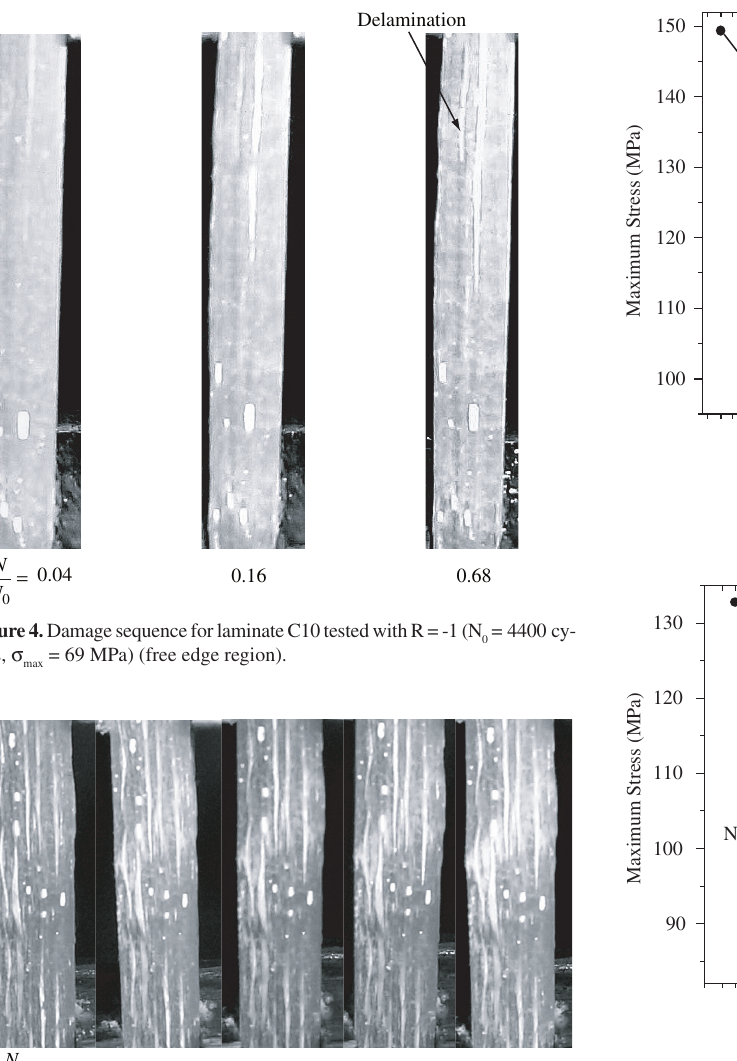
Figure 5. Damage sequence for laminate C12 tested with R = -1 (N = 17500 cycles, σ = 46 MPa) (free edge region). 0 max